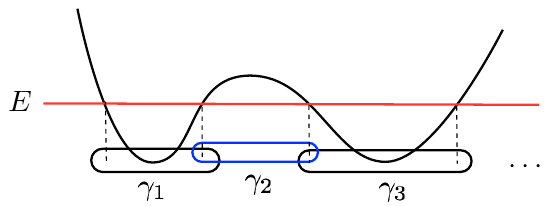
· · · Figure 3 . To derive the TBA system obeyed by the WKB periods, we consider a region in moduli space where the discontinuities of their Borel resummations are encoded by the Delabarere-Pham formula. In this region all the turning points are real and di(cid:11)erent, and we have a sequence of cycles encircling classically allowed and classically forbidden intervals in an alternate